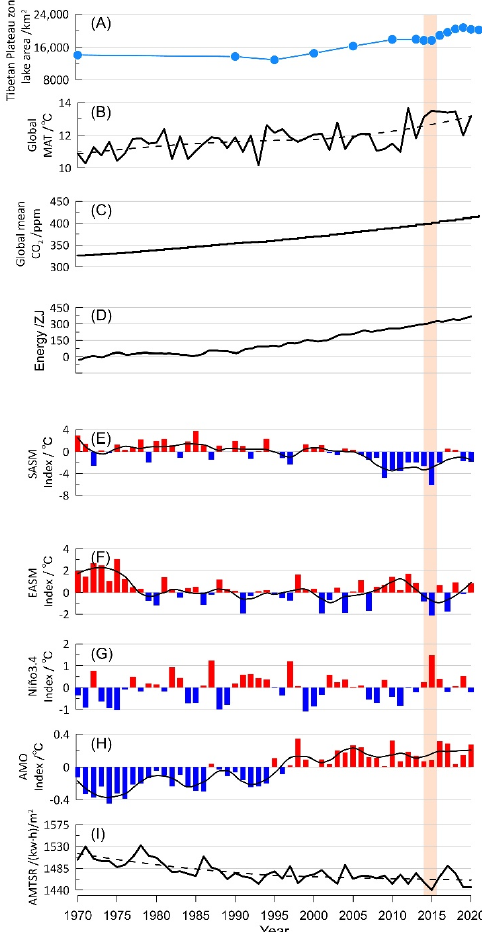
Figure 7. Comparison of lake area changes in the Tibetan Plateau zone and global climatic factors over the past 50 years. ( A ) Changes in lake area in the arid zone of the Tibetan Plateau over the past 50